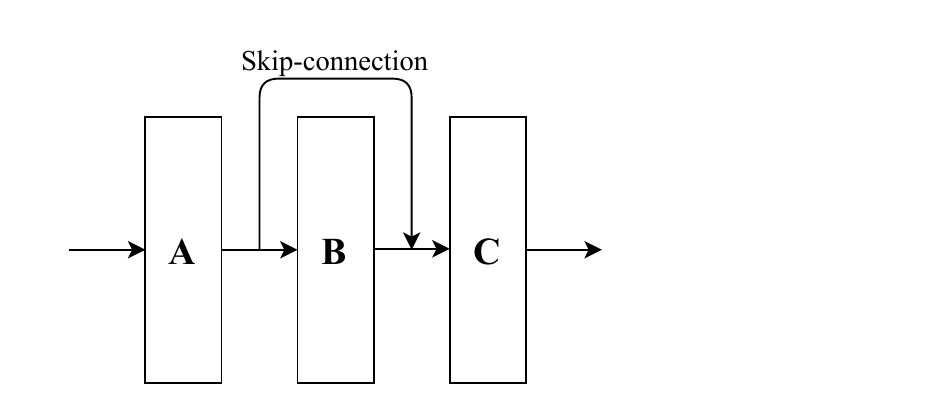
Figure 2. An example of a skipped layer in a Residual Neural Network. There is an additional connection between layers A and C that allows skipping layer B when